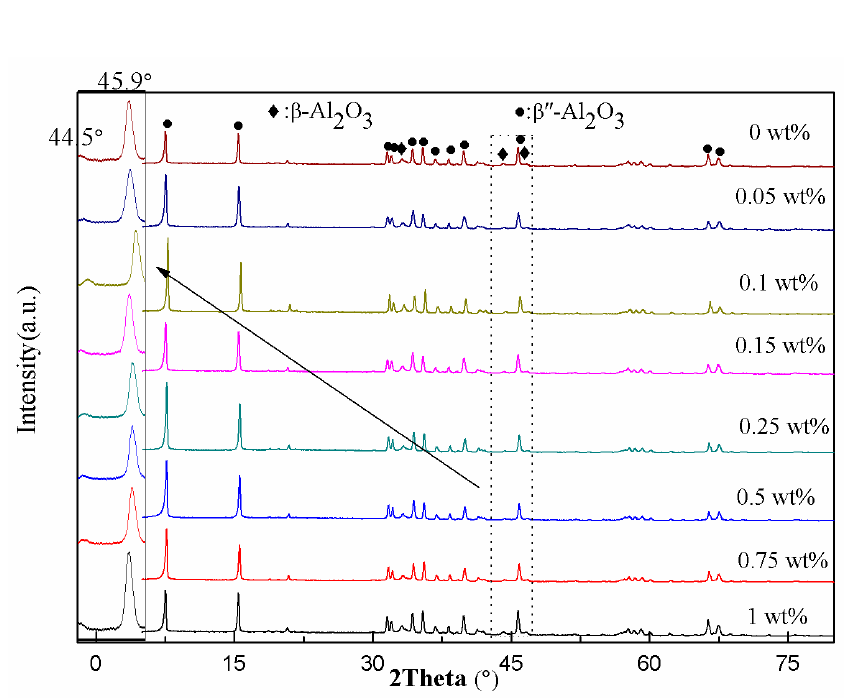
Figure 4. XRD spectra of the sinters for di ff erent amounts of Cr 2 O 3 doping (sintering temperature: